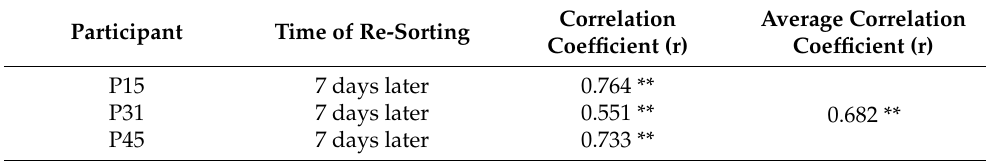
Table 3. Correlation between first and second Q sorting.